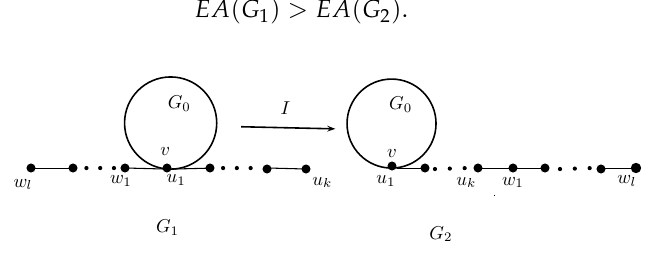
Figure 1. Transformation